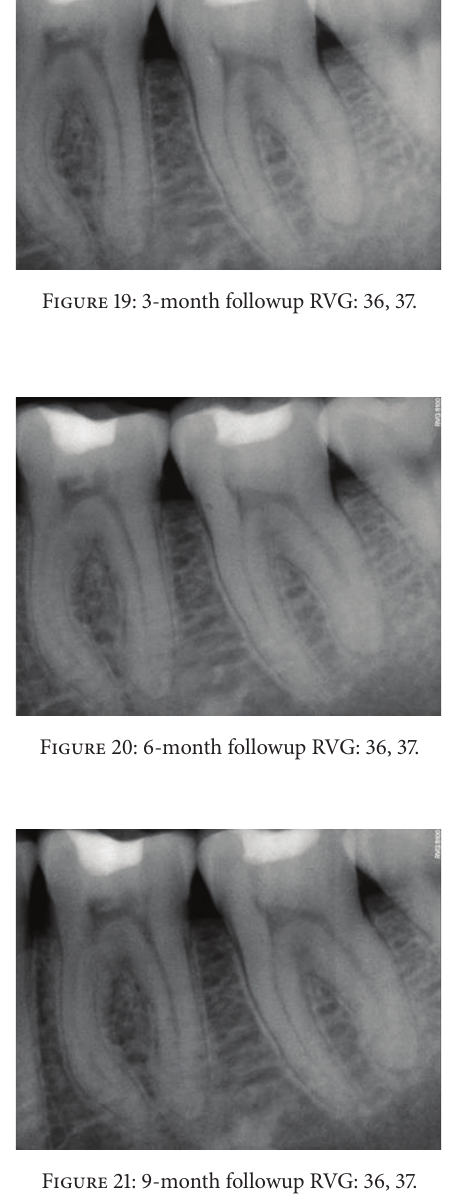
Figure 15: Access opening for pulpotomy procedure: 36, 37.